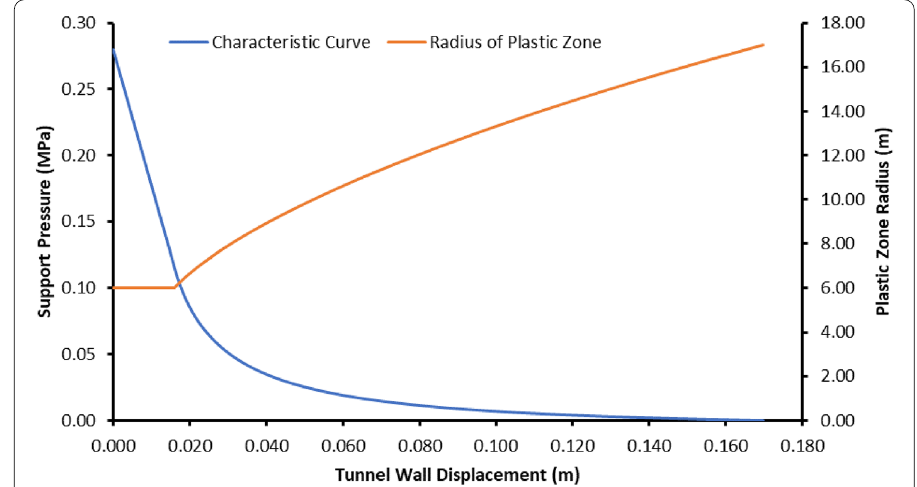
Fig. 10 Characteristic curve for the studied section of the T4 tunnel